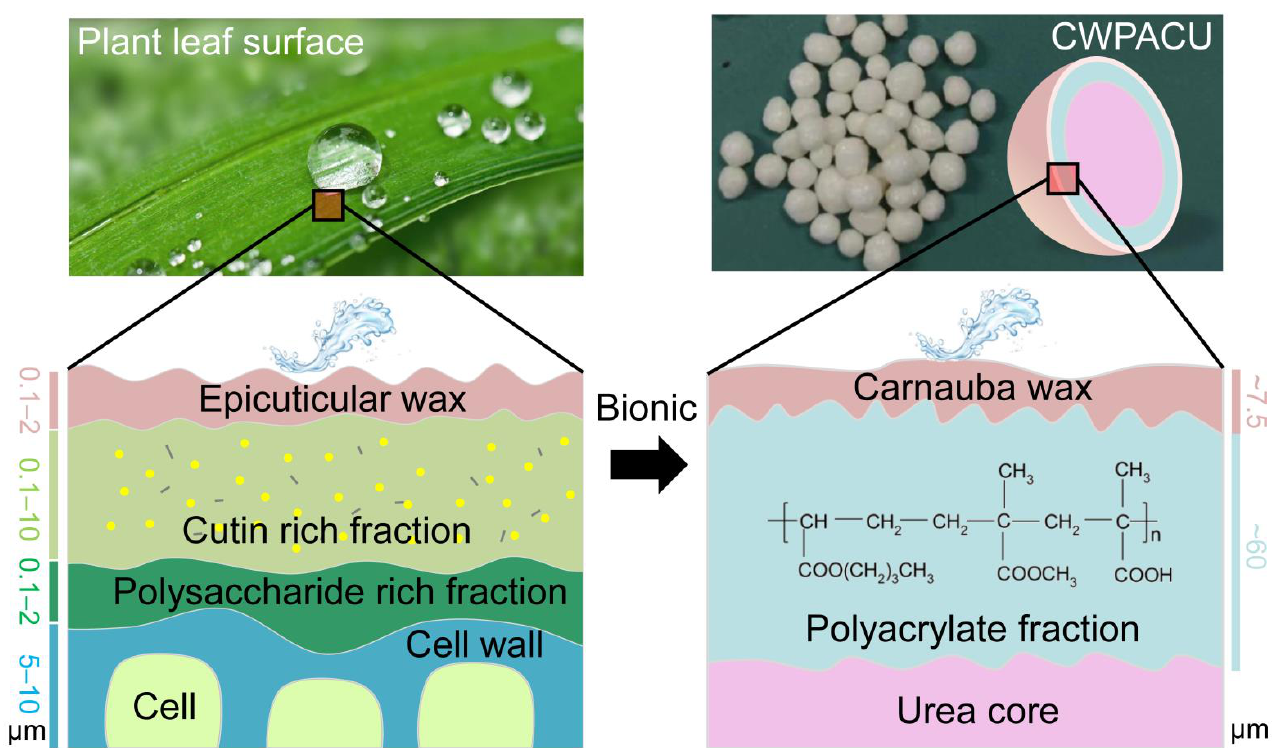
Figure 7. The carnauba wax-modified polyacrylate bionic double coating for controlled release fertilizer regarding the structure of plant leaf cuticle.